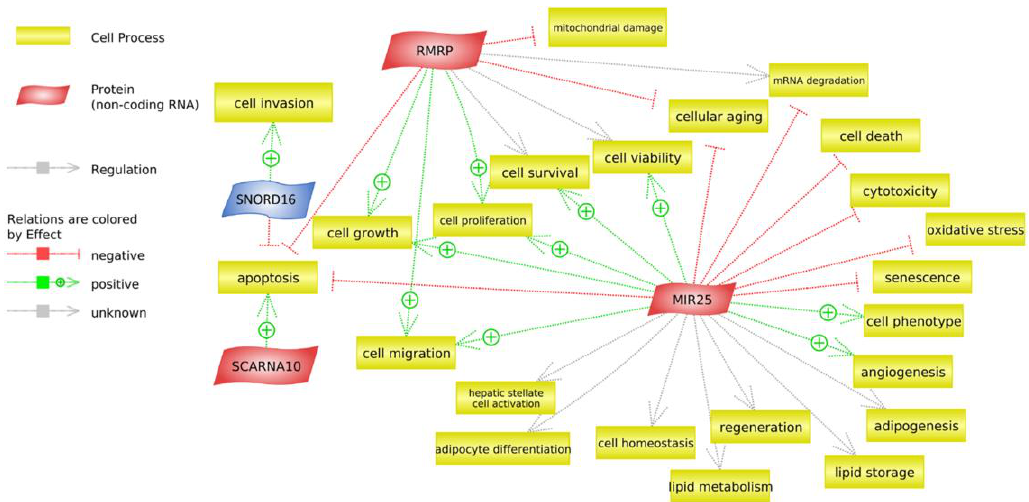
Figure 6. The main cellular processes for non-coding differentially-expressed RNAs associated with the RFI trait using the Pathway Studio software. The cellular processes are highlighted in yellow rectangles. The non-coding RNAs highlighted in red are up-regulated in the LRFI, the blue rectangles present the down-regulated non-coding RNA in the LRFI group compared with the HRFI; green arrows indicate a positive regulation effect, while red arrows indicate a negative regulation effect and gray arrows indicate an unknown regulation effect.